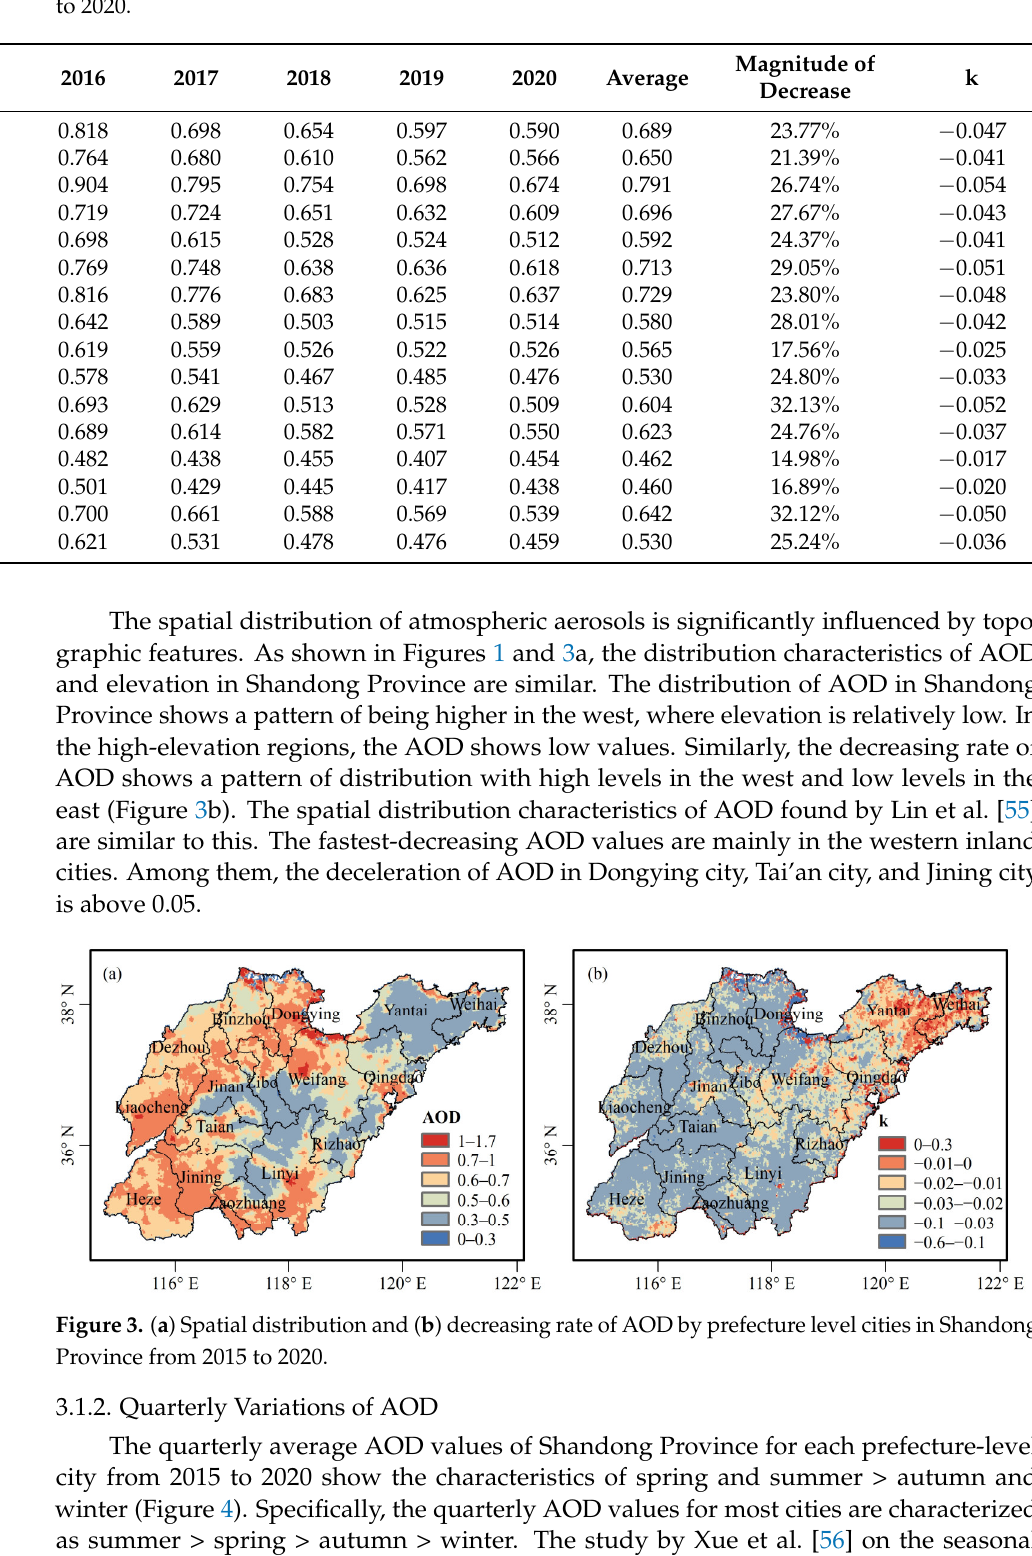
Table 2. Interannual variations of AOD by prefecture-level cities in Shandong Province from 2015 to 2020.